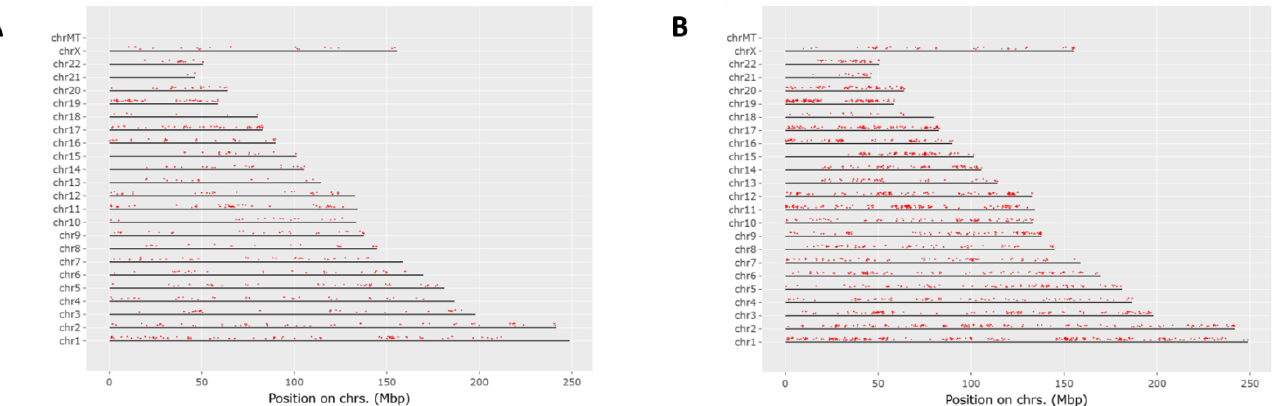
Figure 4. Chromosomal mapping of down regulated proteins at the 3 h mark ( A ) and the 24 h mark ( B ). This shows a wide chromosomal effect of HD exposure over time leading to the dysregulation of multiple proteins.